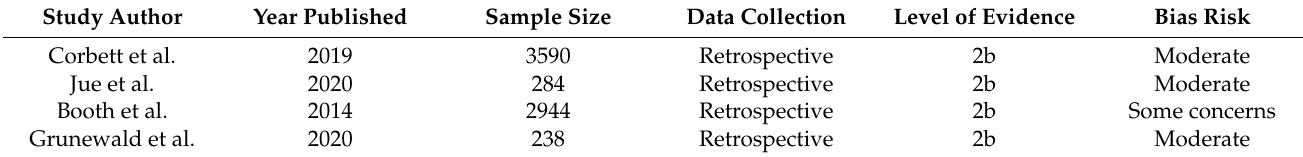
Table 1. Data Collection Type.